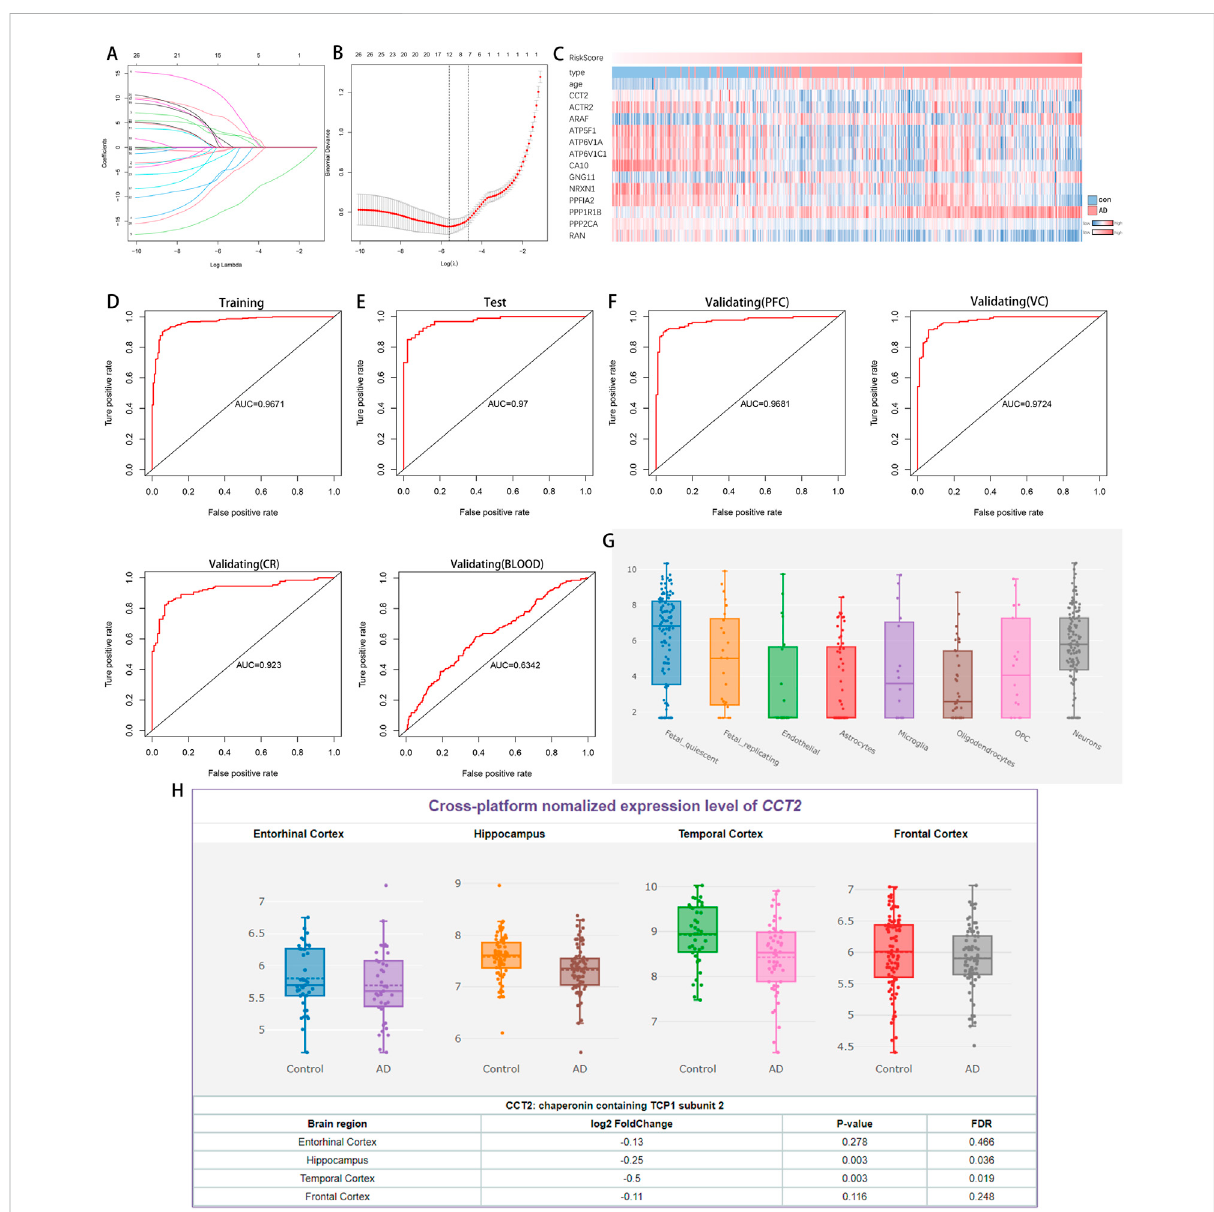
FIGURE 4 Alogisticmodelfor identifying Alzheimer ’ sdisease (AD)and theexpression ofChaperonin containing TCP1subunit2(CCT2)indifferenttissues and cells. (A – B) Least absolute shrinkage and selection operator (LASSO) model. (C) Heatmap demonstrates changes in category, age, and gene expression as predictivescores rise. (D) Receiver operating characteristic(ROC) curve analysis ofthe training set (GSE33000). (E) ROC curve analysis of the validation set (GSE33000). (F) The ROC curve analysis of the external validation set (GSE44768, GSE44770, GSE44771, and GSE140829). (G) CCT2 expression observed in various cells of the brain. (H) CCT2 was signi fi cantly downregulated in various brain regions of patients with